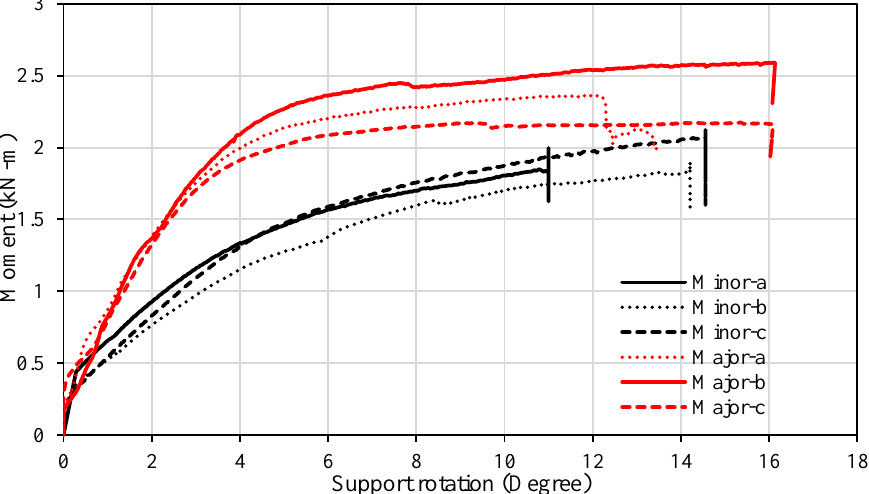
Figure 12. Moment vs. rotation curves for Ø 8 mm bolted spline connections with a 8mm-thick steel plate when tested along the major and minor axes.